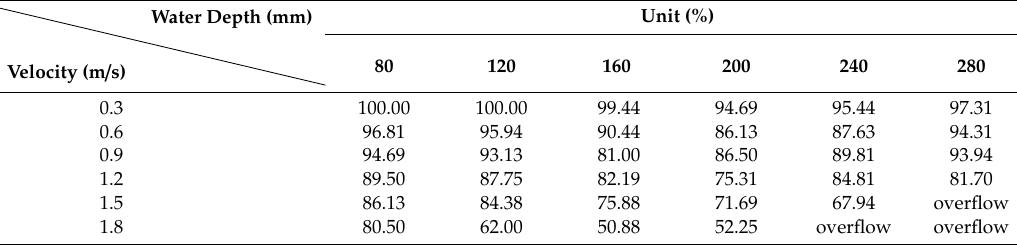
Table 7. Capture efficiency of the driftwood capture trellis by experimental conditions.